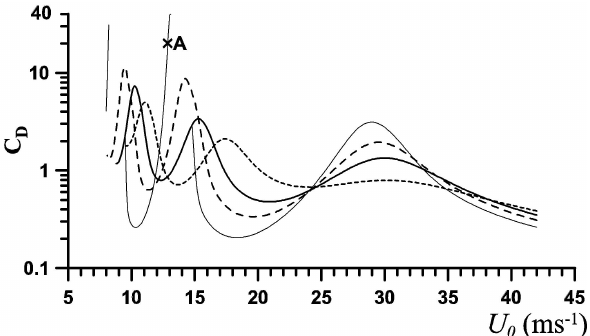
Fig. 7. Drag coefficient for the three-layer hydrostatic solution as a function of U 0 for the Scandinavian mountains, case b, depending on the lapse rate in the middle layer (7km ≤ z ≤ 10km): 9K / km (thin solid), 8K / km (long dashed), 7K / km (solid), and 5K / km (short dashed). The lapse rates in the bottom and upper layers are 7K / km and 0K/km, correspondingly.